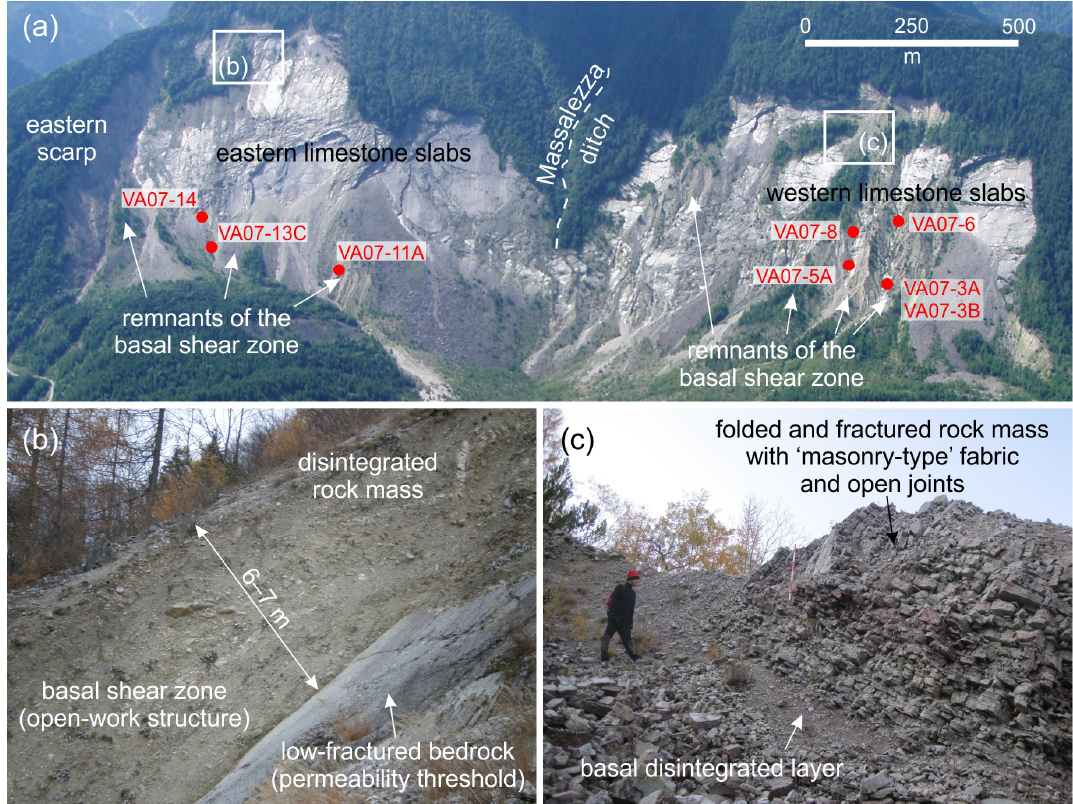
Figure 4. ( a ) Failure scar of the 1963 Vajont landslide, showing widespread presence of remnants of the basal shear zone. The location and code of some clay samples are also shown. ( b ) Basal contact between the main rupture surface and the overlying debris of the shear zone. ( c ) Displaced and stratified rock mass “wrapped” by a layer made up of angular gravel.